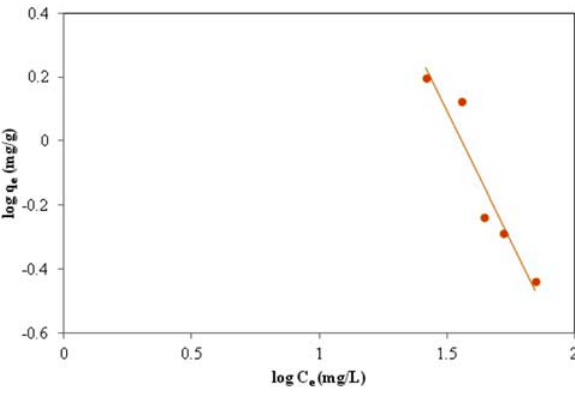
Figure 14. Freundlich isotherm of AY 17